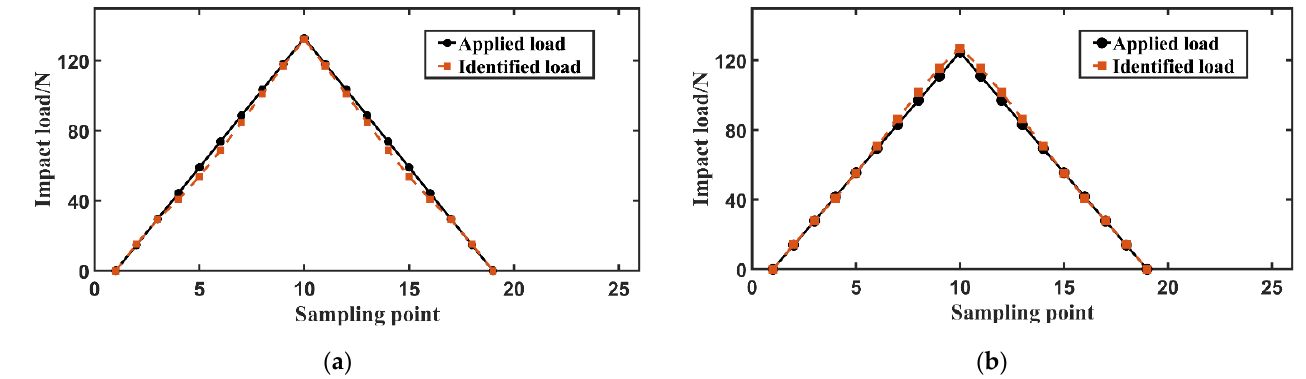
Figure 19. Impact load identification effect in standardized pattern of two working conditions. ( a ) Single pylon. ( b ) Double pylon.